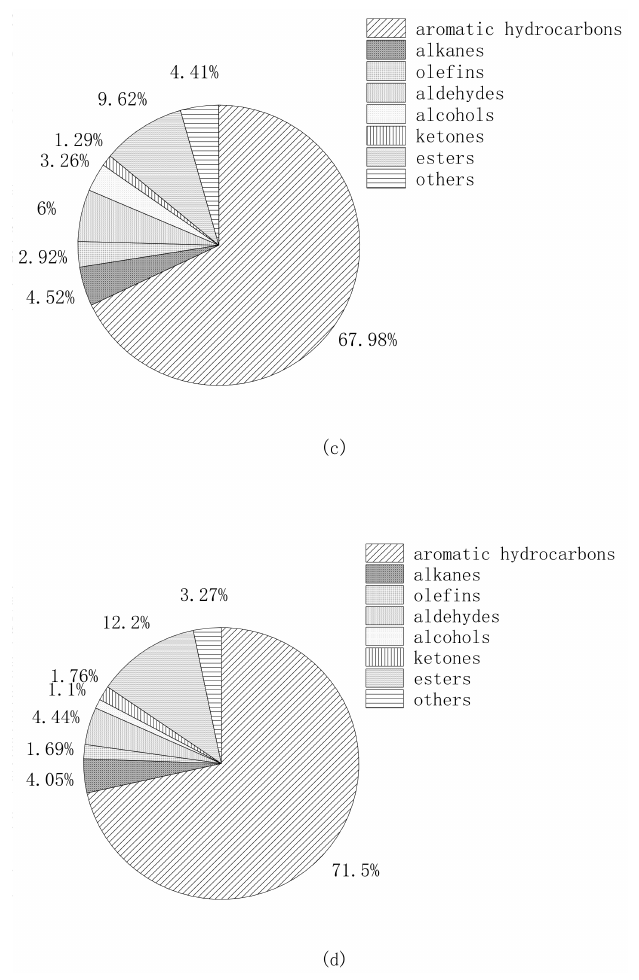
Figure 3. Proportion of VOCs released from PVC-P ( a ), MI-P ( b ), UF-P ( c ) and WP-P ( d ) at 30